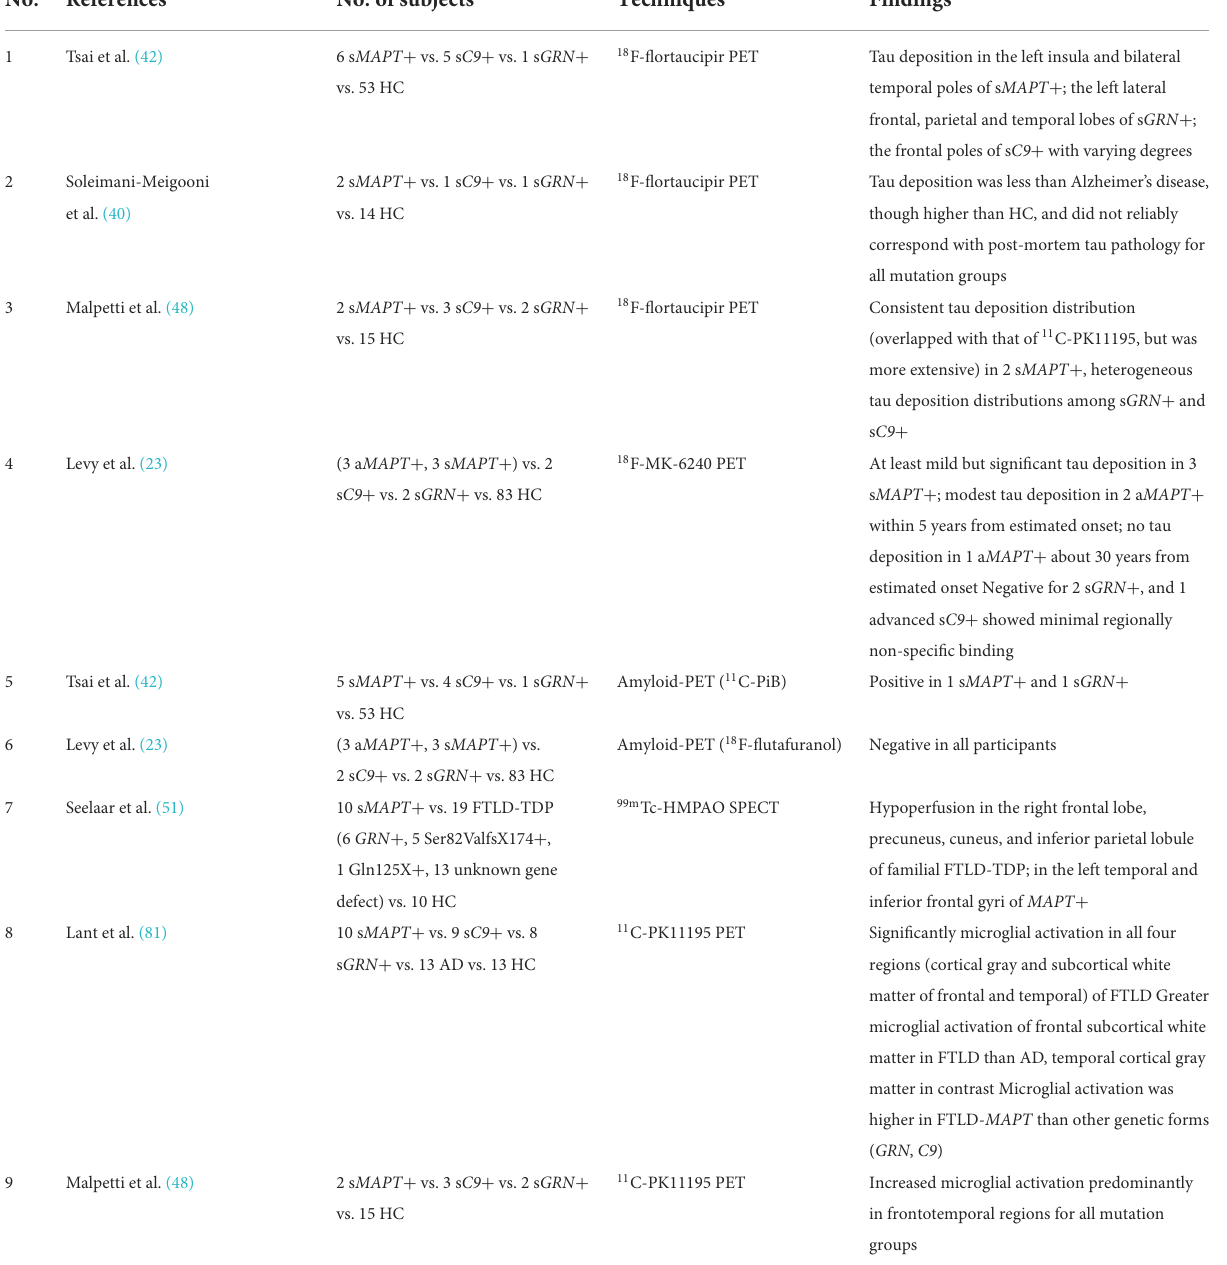
TABLE 4 Studies investigating multiple different mutations in FTLD.